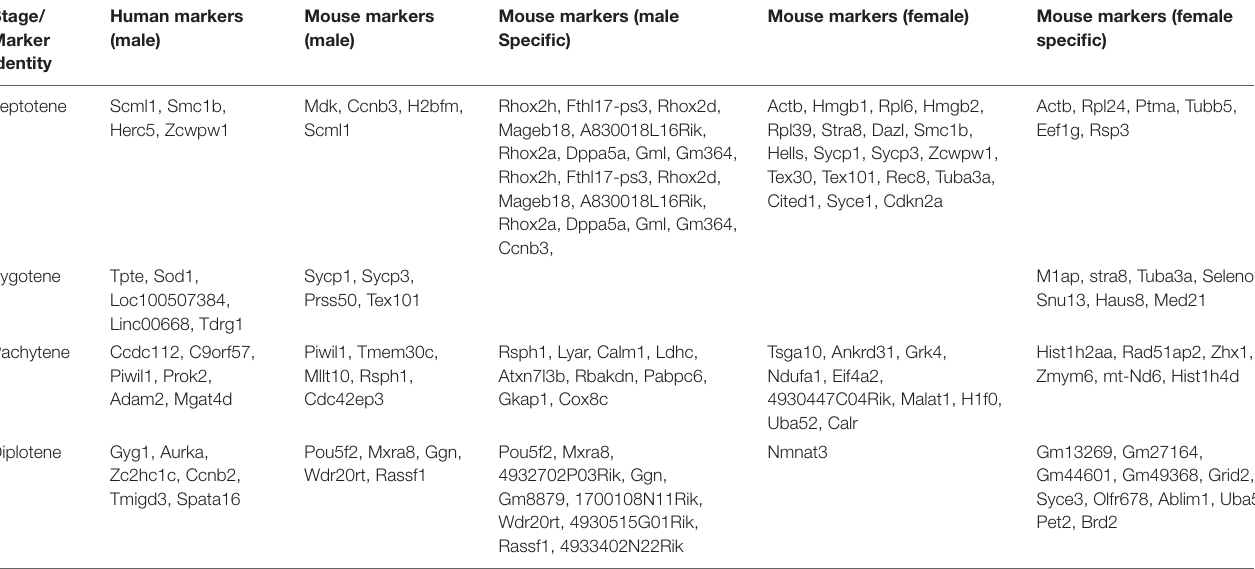
This table summarized markers for four substages in meiosis prophase I. Human and mouse markers were listed. Those markers come from different resources (see citations in the text). Markers in the table were identified from the total 13 publications. Specifically, the meiotic markers for male are generated by comparing differentiated genes at same or similar stage from different scRNA-seq datasets, all the marker genes selected were identified as markers by DGE analysis from at least 2 different studies to ensure the consistency. For mouse female meiotic markers, all the data comes from Niu and Spradling (2020) because this study is the only high throughput Drop-seq study that dissect transcriptomic features of oocytes in a fine scale. We also create male and female specific marker list by comparing Niu’s study to Drop-seq based male studies that targeted at similar meiotic stages. Genes that were identified as significant differentiated-expressed genes (p < 0.05) at certain stage in either male or female were put into the